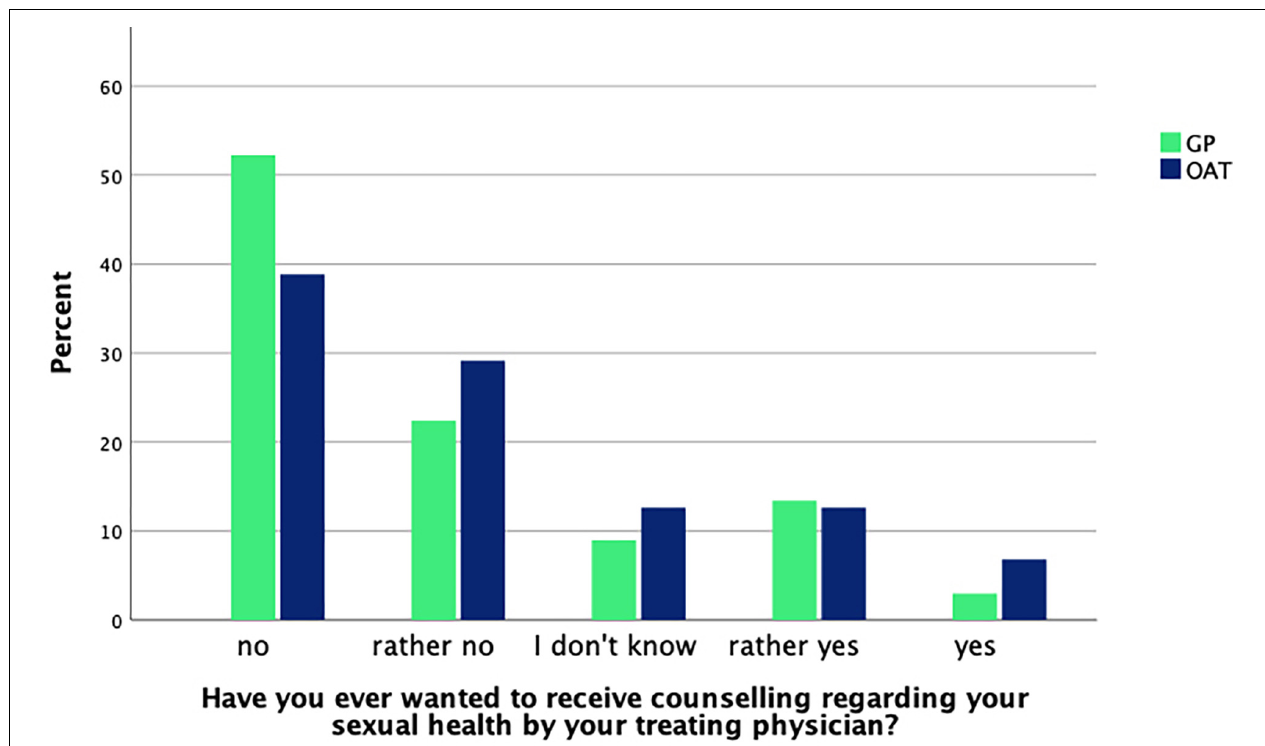
FIGURE 1 | GP ( n = 67) and OAT ( n = 103) patients’ answers about whether they ever felt the need for counseling.